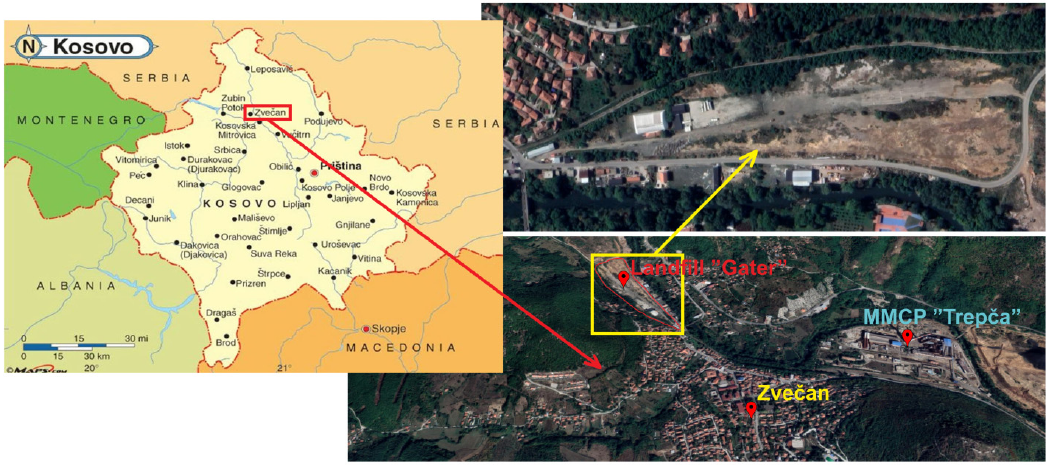
Figure 1. Location of the Gater Landfill in relation to settlements and industrial facilities.